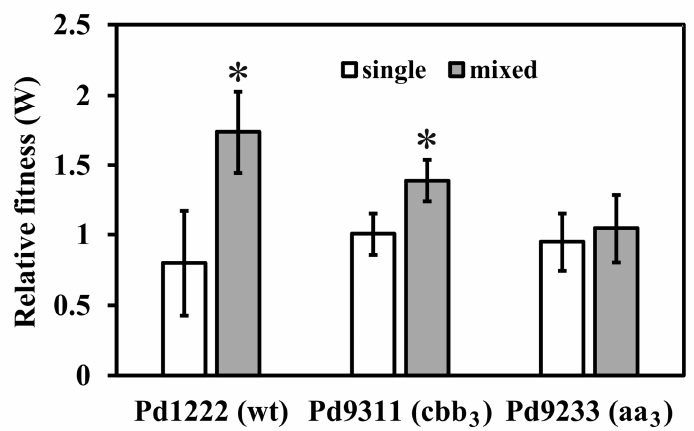
Figure 1. Relative fitness (W) of P. denitrificans strains versus the Pd9312 ( ba 3 ) strain as a reference. The results are from five separate experiments and represent means ± standard deviation (S.D.). Left bars, separate cultures; right bars, 1:1 mixed culture. The asterisk denotes statistically significant difference between the respective mixed culture and separate cultures (paired t -test, p < 0.01). There is no significant di ff erence (analysis of variance (ANOVA), p = 0.48) in the W values for separate cultures (left bars) and none of these values di ff ers significantly from 1 (one sample t -test, p >